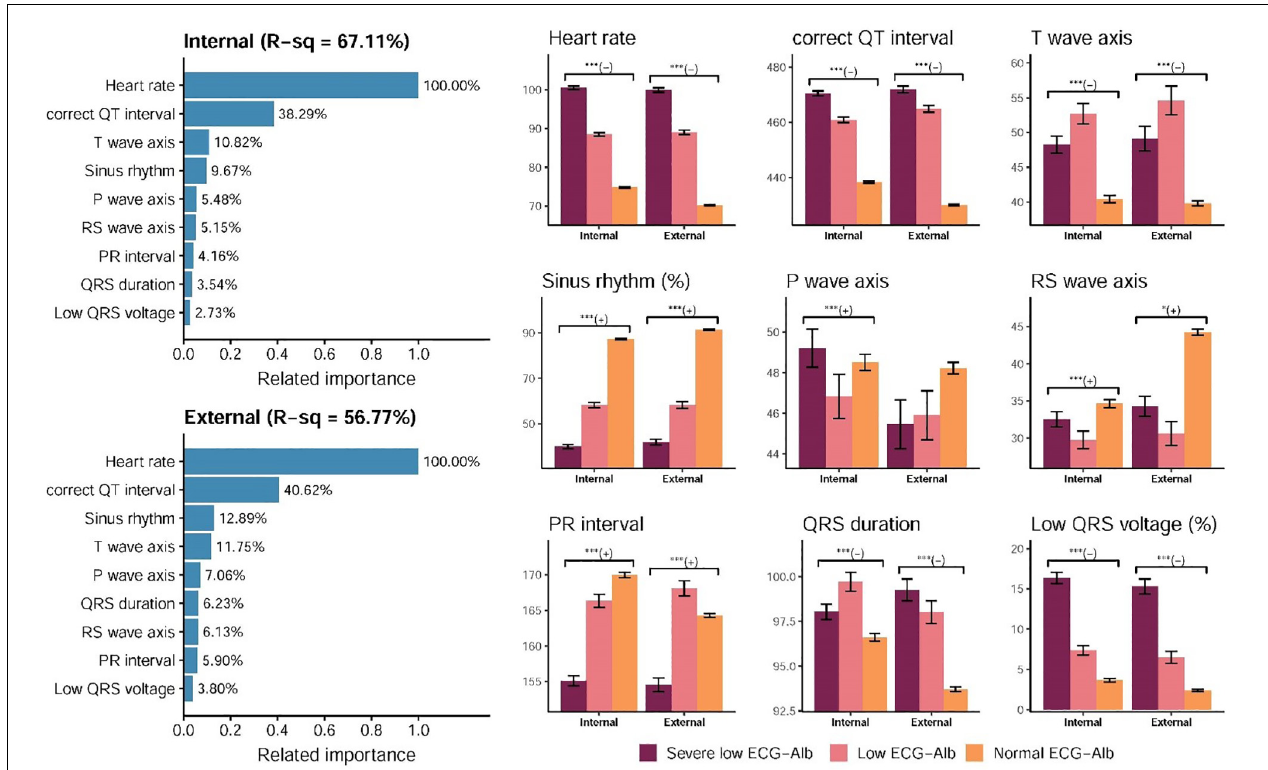
FIGURE 4 | Relationship between the selected ECG features and predicted albumin (ECG-Alb). The related importance is based on the information gain of the XGB model, and the R-square (R-sq) is the coefficient of determination to use selected ECG features for predicting ECG-Alb. The AI-ECG predictions were classified as normal ECG-Alb, low ECG-Alb, and severe low ECG-Alb based on the operating points, as in the previous ROC curve analysis. The analyses are conducted both in internal and external validation sets ( ∗ p for trend < 0.05; ∗∗∗ p for trend <